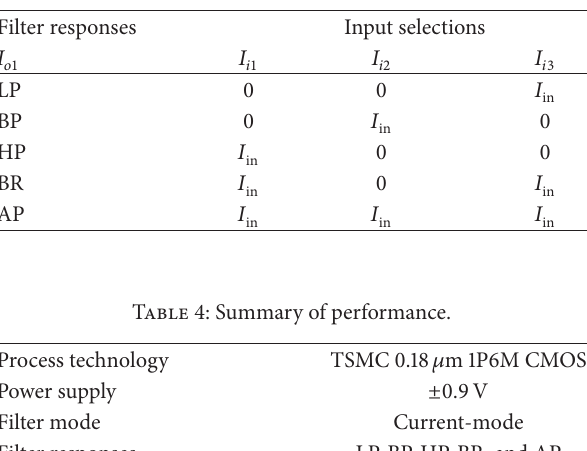
Table 3: The 𝐼 𝑖1 , 𝐼 𝑖2 , and 𝐼 𝑖3 values selection for each filter function response.